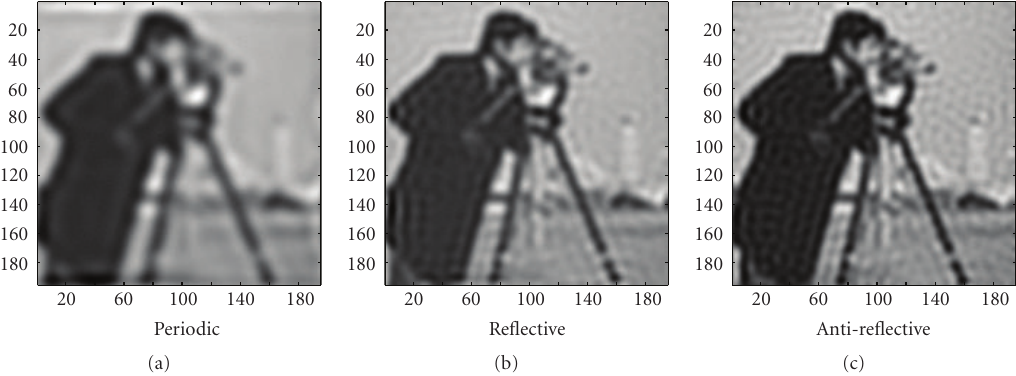
Figure 5: Restored images with SNR = 40.